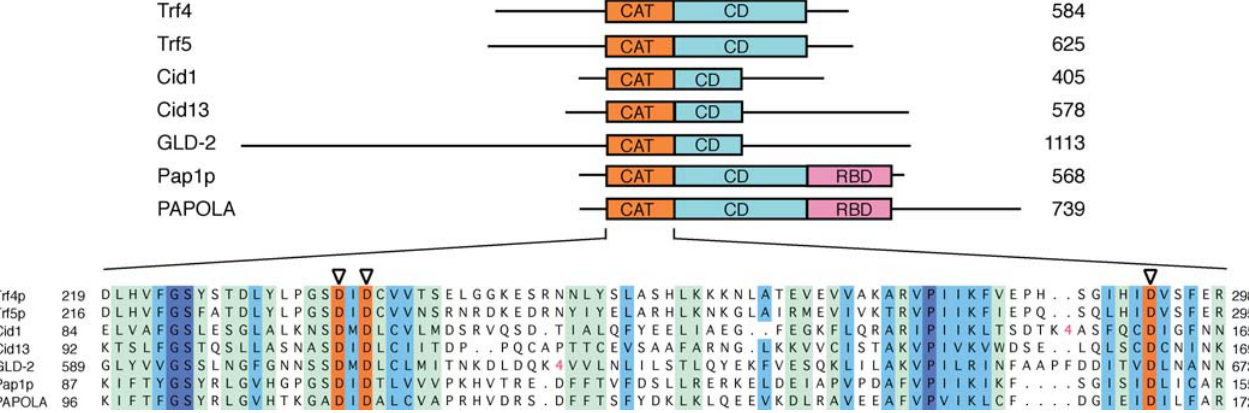
Figure 1. Schematic Alignment of the Domain Organization of Trf4p and Trf5p with Other Members of the Pol- b -like Nucleotidyltransferase Family The proteins are represented as lines, with conserved regions shown as boxes (CAT, catalytic domain; CD, central domain; RBD, RNA-binding domain; sizes in amino acids are indicated to the right). The green boxes in the sequence alignment mark regions with 50% similarity, light blue boxes indicate 100% similarity, and dark blue and orange boxes are regions with 100% identity. The three conserved catalytic aspartates at positions 236, 238, and 294 are in orange and marked by triangles. Regions with four additional amino acids present in Cid1 and GLD-2 are marked with a orange ‘‘ 4. ’’ DOI: 10.1371/journal.pbio.0030189.g001 PLoS Biology |